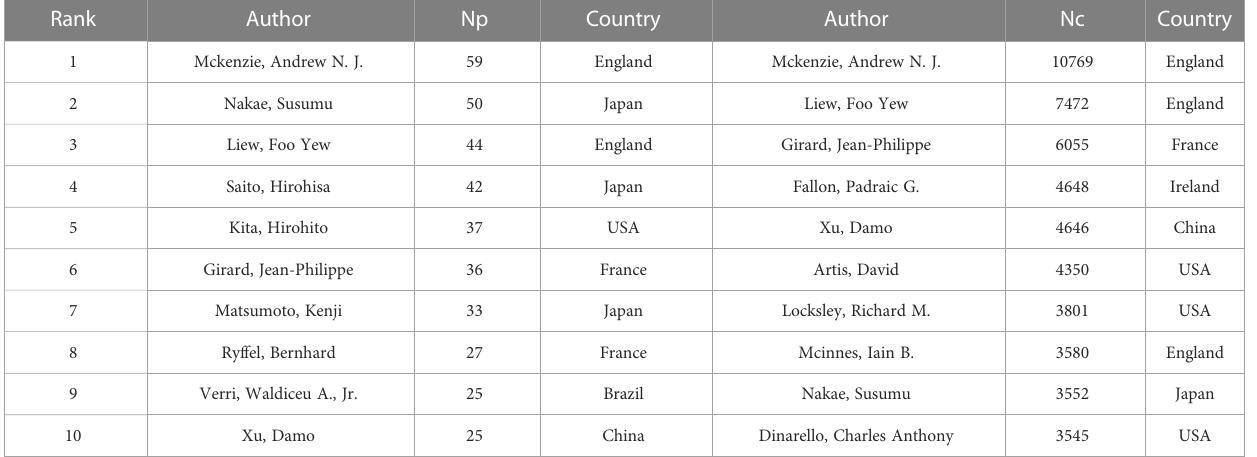
TABLE 4 The top 10 productive authors with publications and citation frequency concerning IL-33. Rank